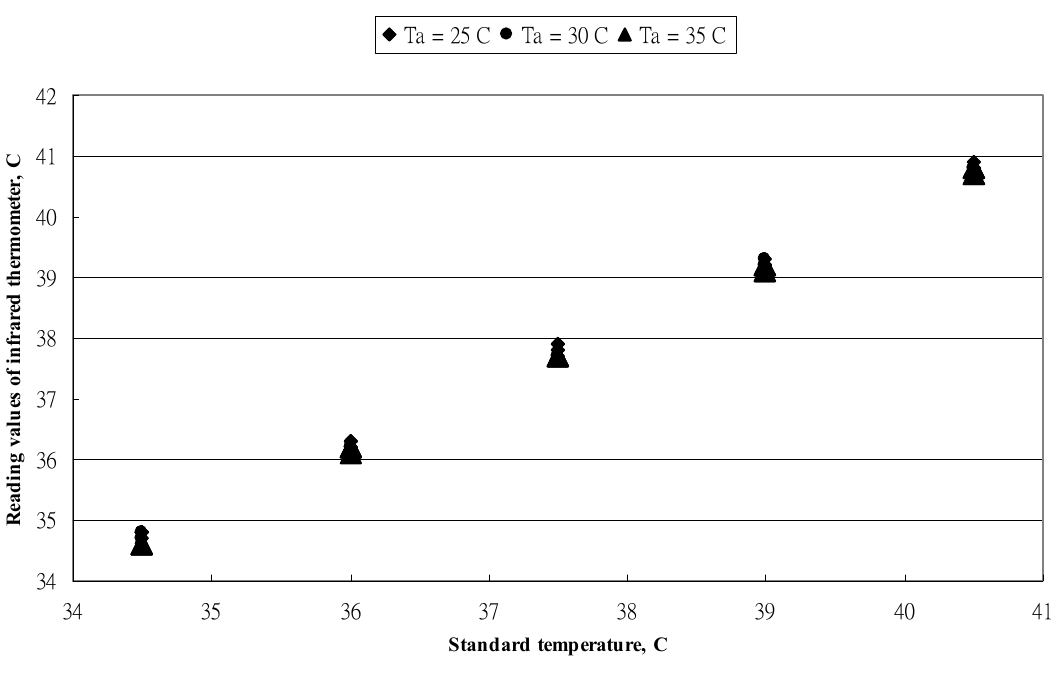
Figure 4. The relationship between reading values of BRAUN IRT-3020 thermometer versus standard values.